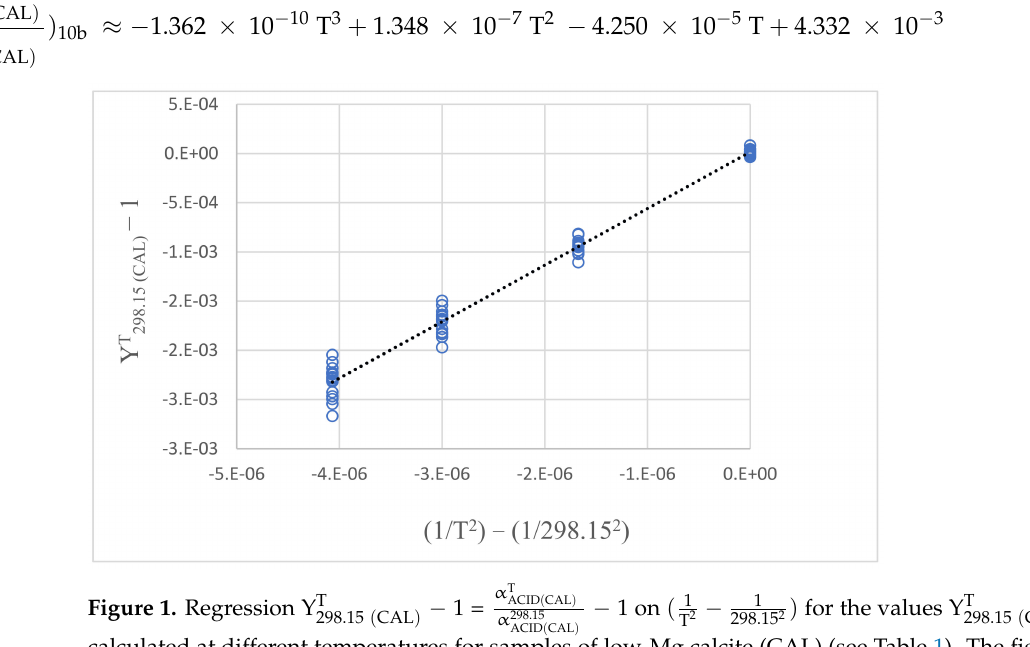
Figure 1. Regression Y T calculated at different temperatures for samples of low-Mg calcite (CAL) (see Table 1). The figure evidences the increasing of the data as the ( 1